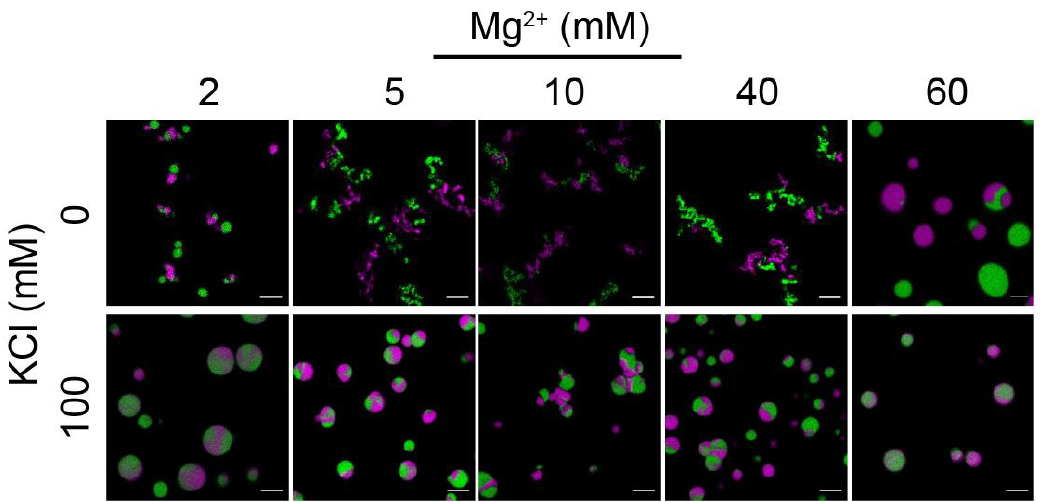
Figure 3. Two-color mixing assay characterization of the phase separation states of 15-197-601 nucleosome arrays. Confocal fluorescence microscopy images of samples at conditions with various KCl and MgCl 2 concentrations are shown. Nucleosomes arrays containing histone H2B T116C labeled with AF488 (green) or AF647 (purple) were treated with phase separation buffer separately and were incubated for 30 min before mixing. Then, the mixture was incubated for another 20 min before imaging. The nucleosome array concentration is 375 nM. Scale bar represents 5 μ m.